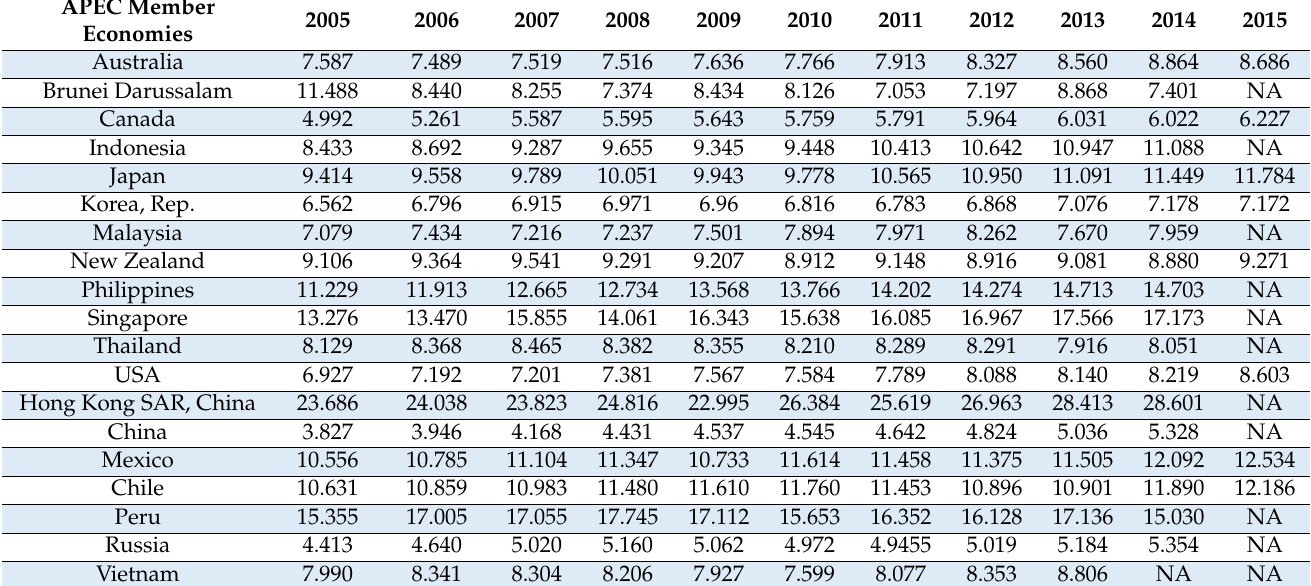
Table A1. GDP per unit of energy consumption (PPP USD per kg of oil